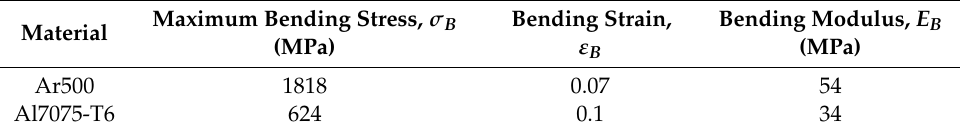
Figure 10. After three-point bending test condition for: ( a ) Ar500 steel; and ( b ) Al7075-T6 alloy. Table 5. Summary of three-point bending test results for each material.